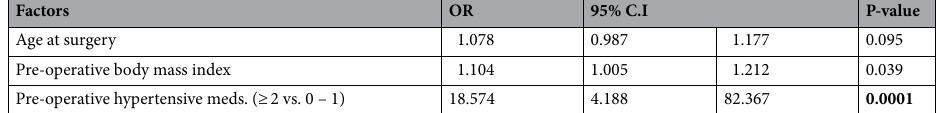
Table 7. Multivariate logistic regression analysis investigating association between clinical factors and hypertension non-resolution. C.I. = Confidence Interval; OR = Odds